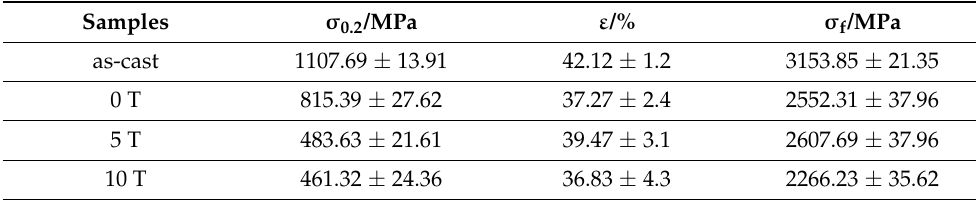
Figure 12. Compressive stress–strain curves for the as-cast, 0 T, 5 T and 10 T samples. Table 3. Yield strength ( σ 0.2 ), ultimate strength ( ε ) and strain to fracture ( σ f ) results for the as-cast, 0 T, 5T and 10 T samples.